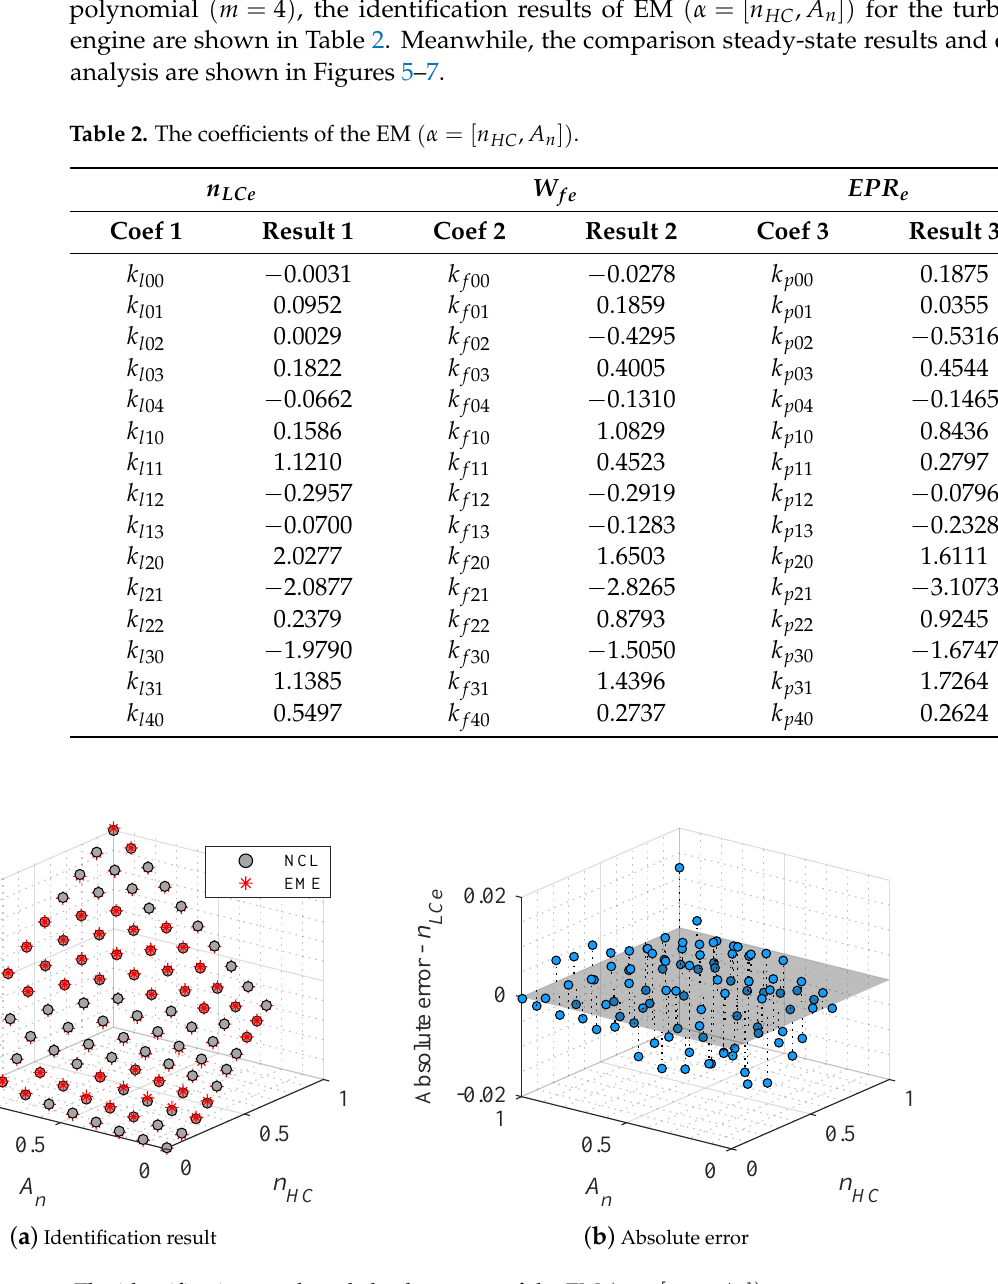
Figure 5. The identification result and absolute error of the EM ( α = [ n HC , A n ]) n LCe